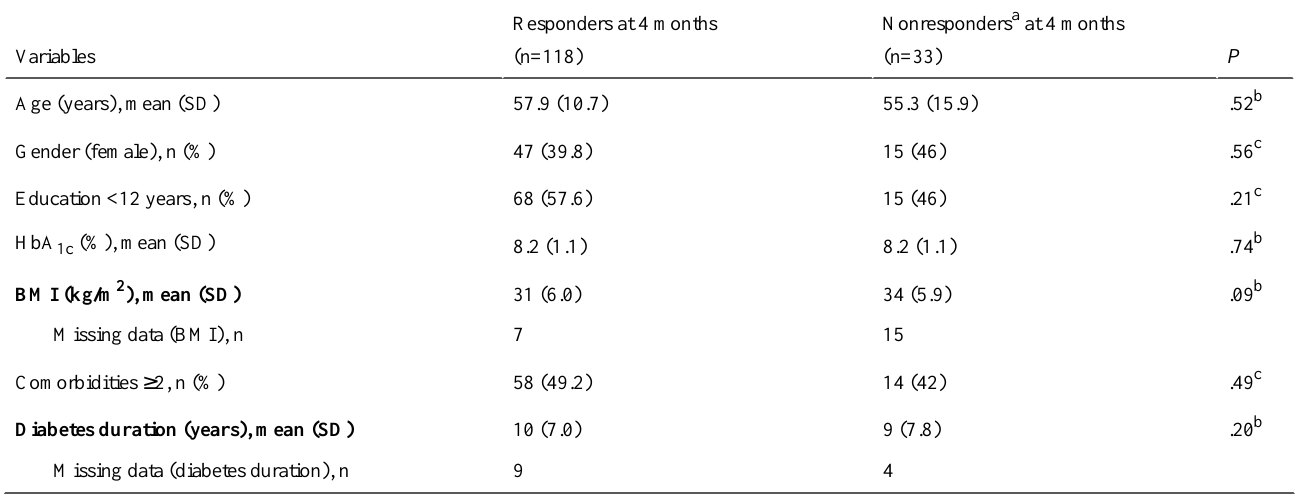
Table 3. Differences between responders and nonresponders at 4 months.